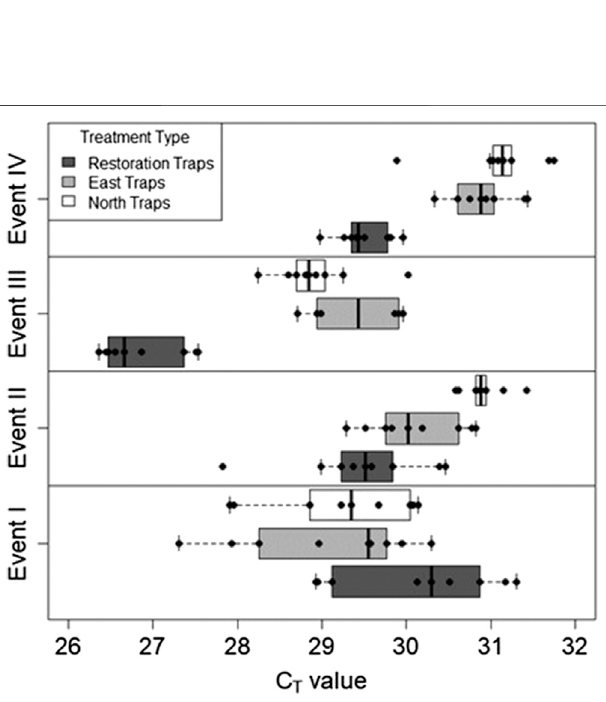
FIGURE4| Thepercentageofsigni fi cantampli fi cation/detectionsforthe traps from all three sampling locations (East, North, and Restoration). The primers focused on honey mesquite airborne eDNA (A) , Bouteloua airborne eDNA (B) , and global plant airborne eDNA (C) .